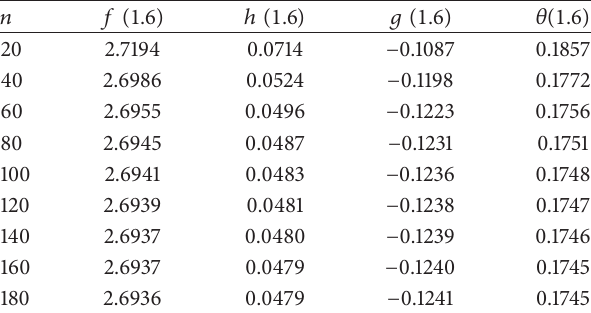
Table 2: Comparison of the flow velocity 𝑓 󸀠 (𝜂) obtained